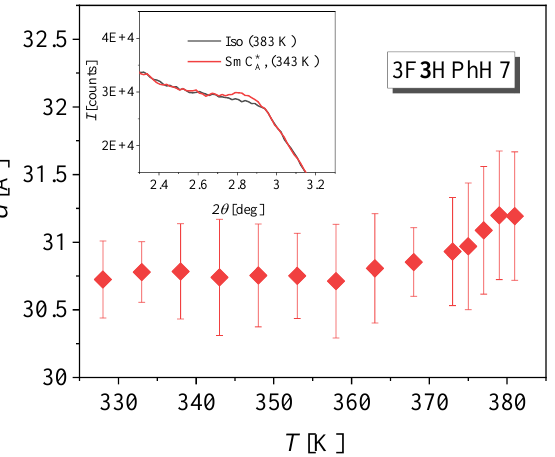
Figure 5. Temperature dependence of the smectic layer spacing d of the 3F 3 HPhH7 obtained on cooling. The inset shows XRD pattern of the 3F 3 HPhH7 in the isotropic liquid (at 383 K) and SmC A * (at 343 K) phases at low 2 θ angles.